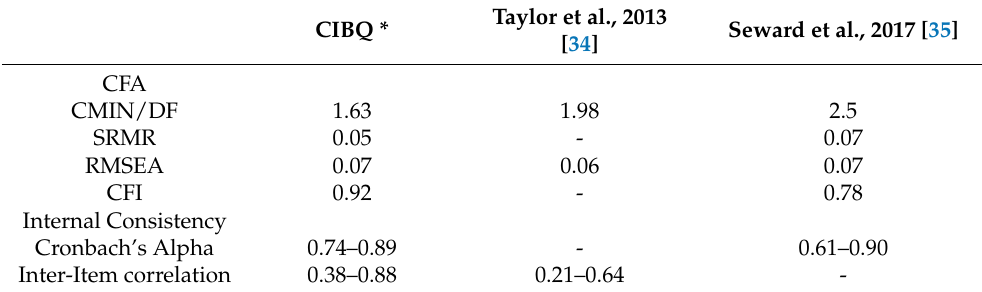
Table 5. Comparison of construct validity and internal consistency of different